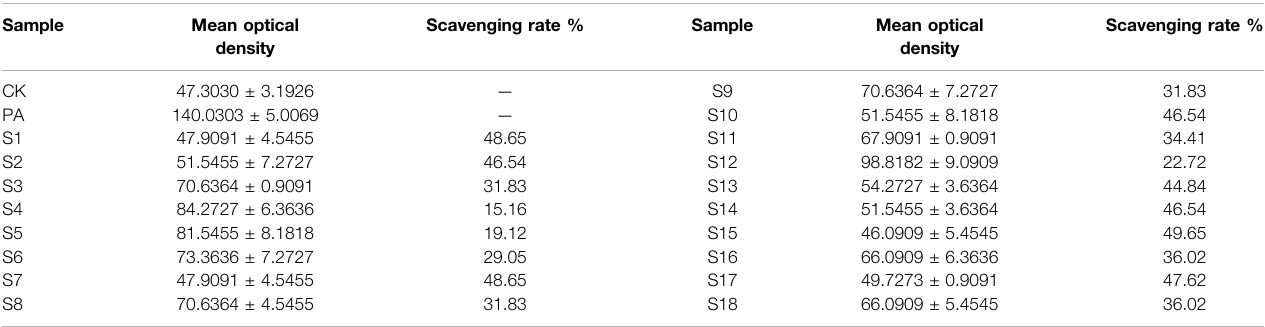
TABLE 4 | The hs-CRP inhibition rate of BBTD extracted from 18 batches (mean ± SD, n = 3).